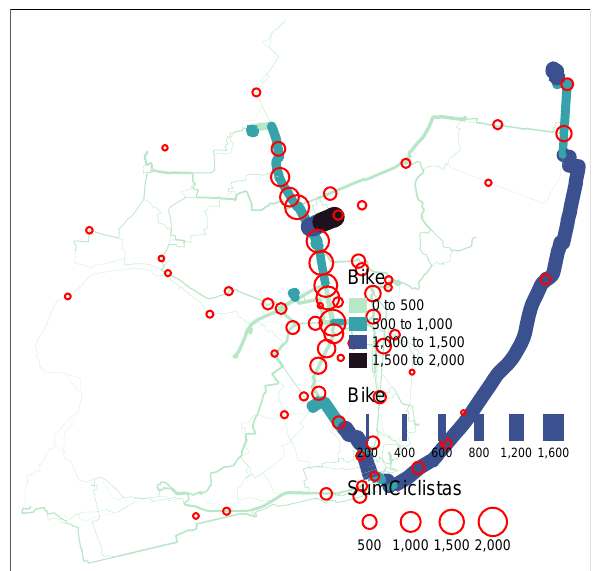
Figure 7. Route network from jittered desire lines with disagregation of 500 trips, with routes from r5r, level of traffic stress 2 (quiet) routing